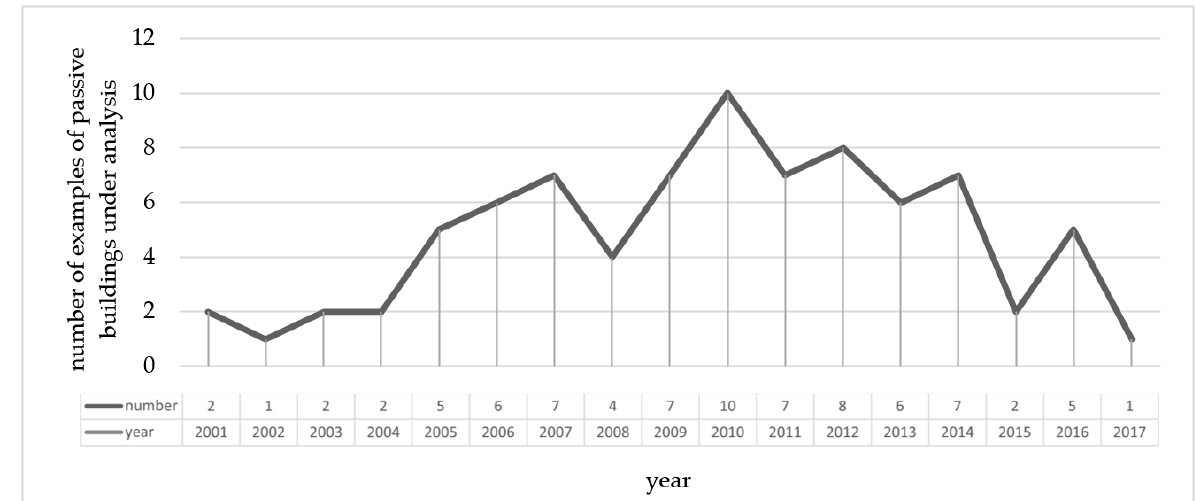
Figure 5. Temporal analysis of passive building implementation.